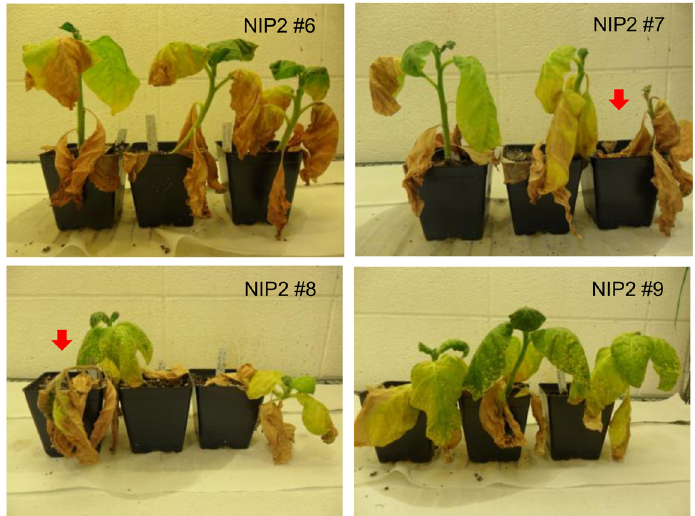
Fig 5. Salt stress test on SspNIP2 transgenic lines. Transgenic plants were irrigated with 100 ml of 200 mM NaCl for 4 weeks and 250 mM NaCl for another 2 weeks. Arrows indicate non-transgenic lines. NIP2 #6, #7, #8 and #9 referred to SspNIP2 transgenic line 6, 7, 8 and 9.